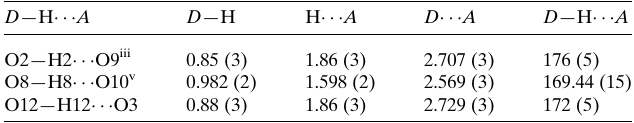
Table 2 Hydrogen-bond geometry (A˚ , (cid:3) ) for RbFe(HAsO 4 ) 2 .